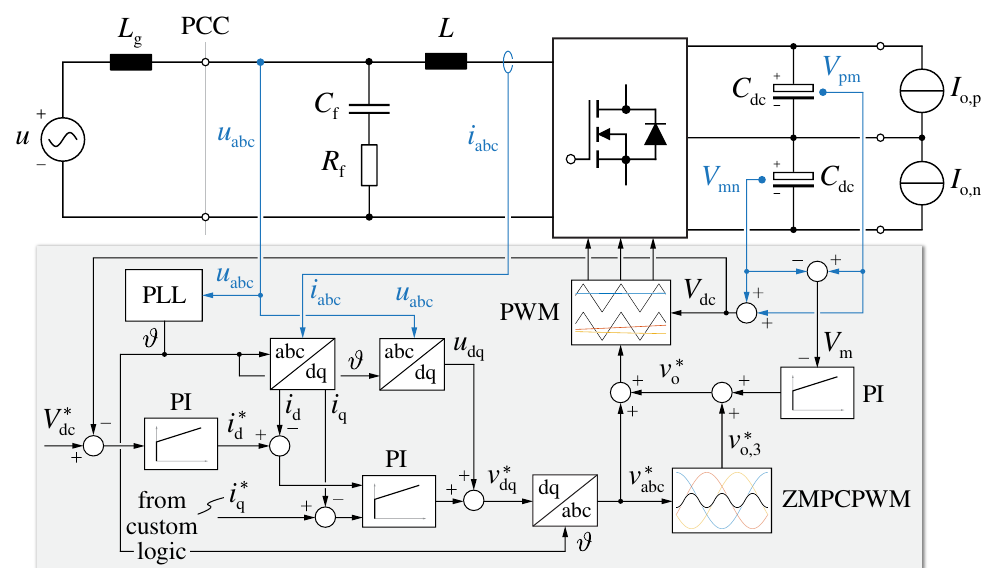
Figure 13. Simplified single-phase equivalent circuit of the considered system and overview of the adopted digital multi-loop control strategy